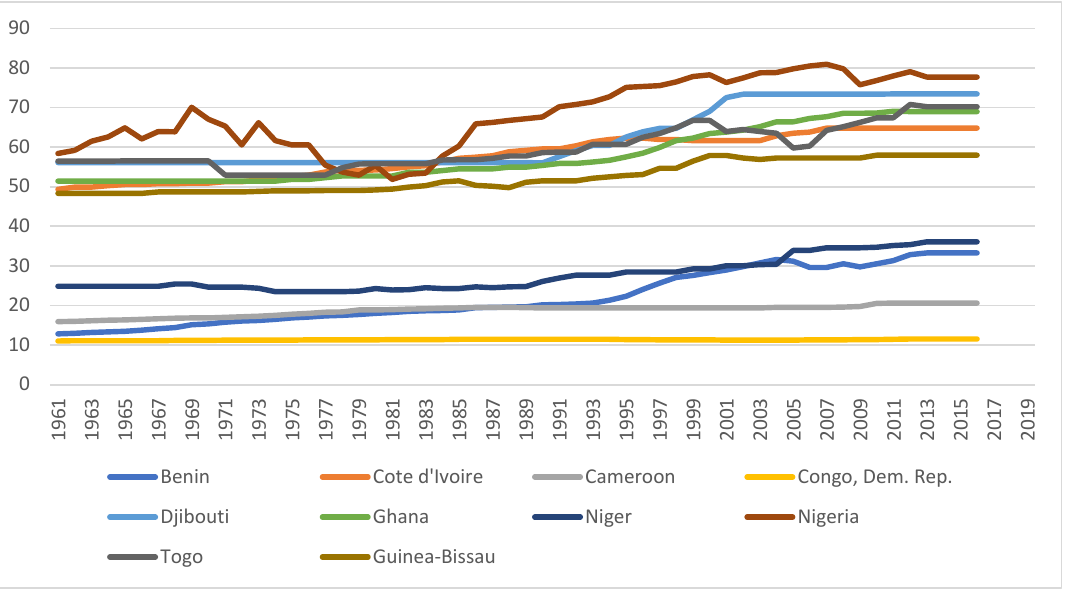
Figure 3. National distribution of agricultural land loss in selected countries in Africa. Source: World Bank Database, FAO Database, (2020).